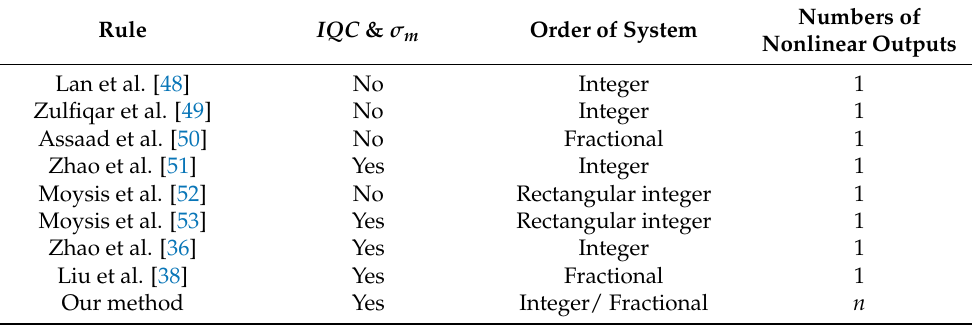
Table 2. Comparison between observers for dynamic